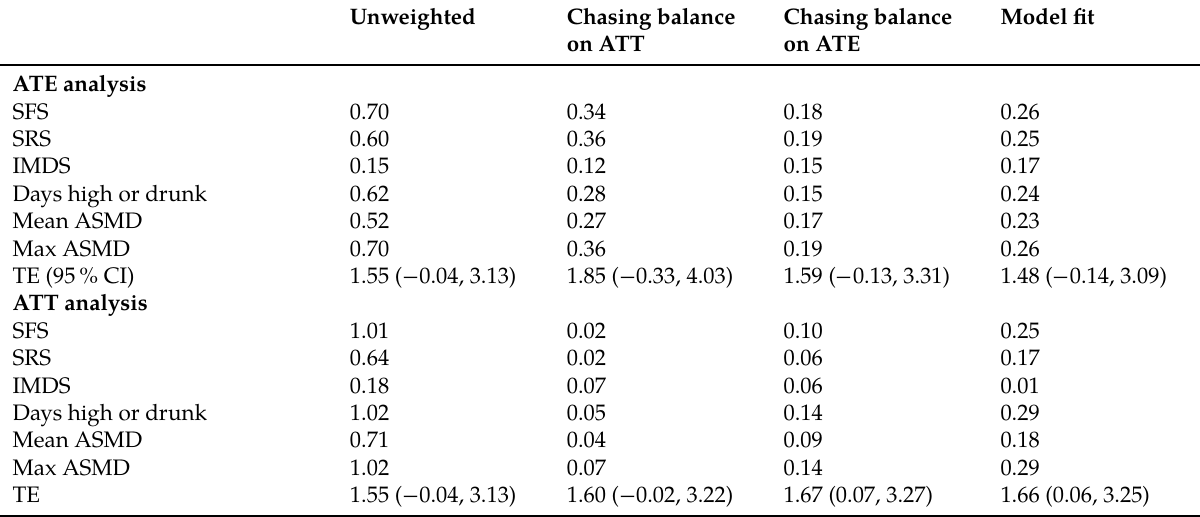
Table 4: ASMD for each pretreatment covariate and summary statistics across covariates as well as treatment effect estimates (standardized) for ATE and ATT analyses for each candidate approach to select optimal iteration of GBM for the abstainers versus drug users